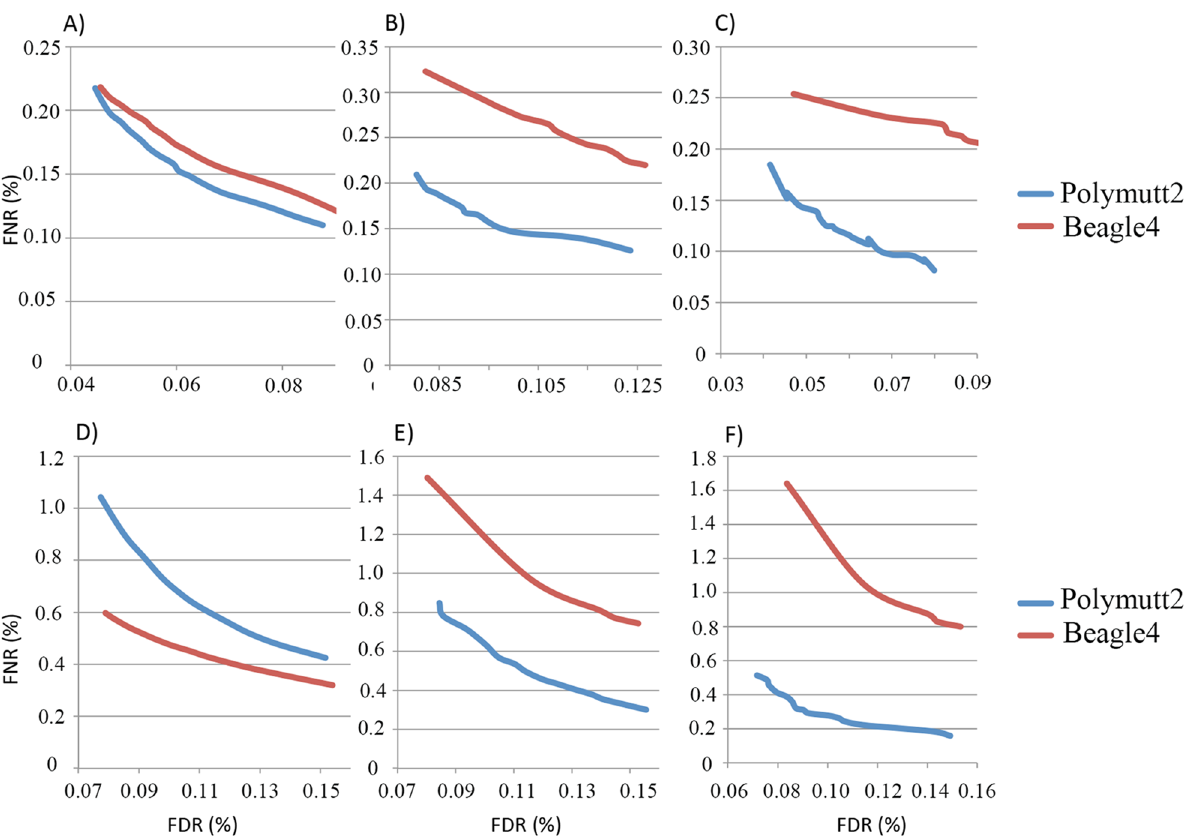
Fig 7. FNR (%) vs. FDR (%) curves of the overall genotypes of Polymutt2 and Beagle4 calls when 30% (~15X, panel A, B and C) or when 15% (~7.5X, panel D, E and F) of the original data were used for genotype calling. Panel A) and D) are for all variants, and panel B) and E) are for variants with MAF < 0.01 and panel C) and F) are for variants with MAF < 0.05. See Application to real data for the details on the pedigree and the calculation of error